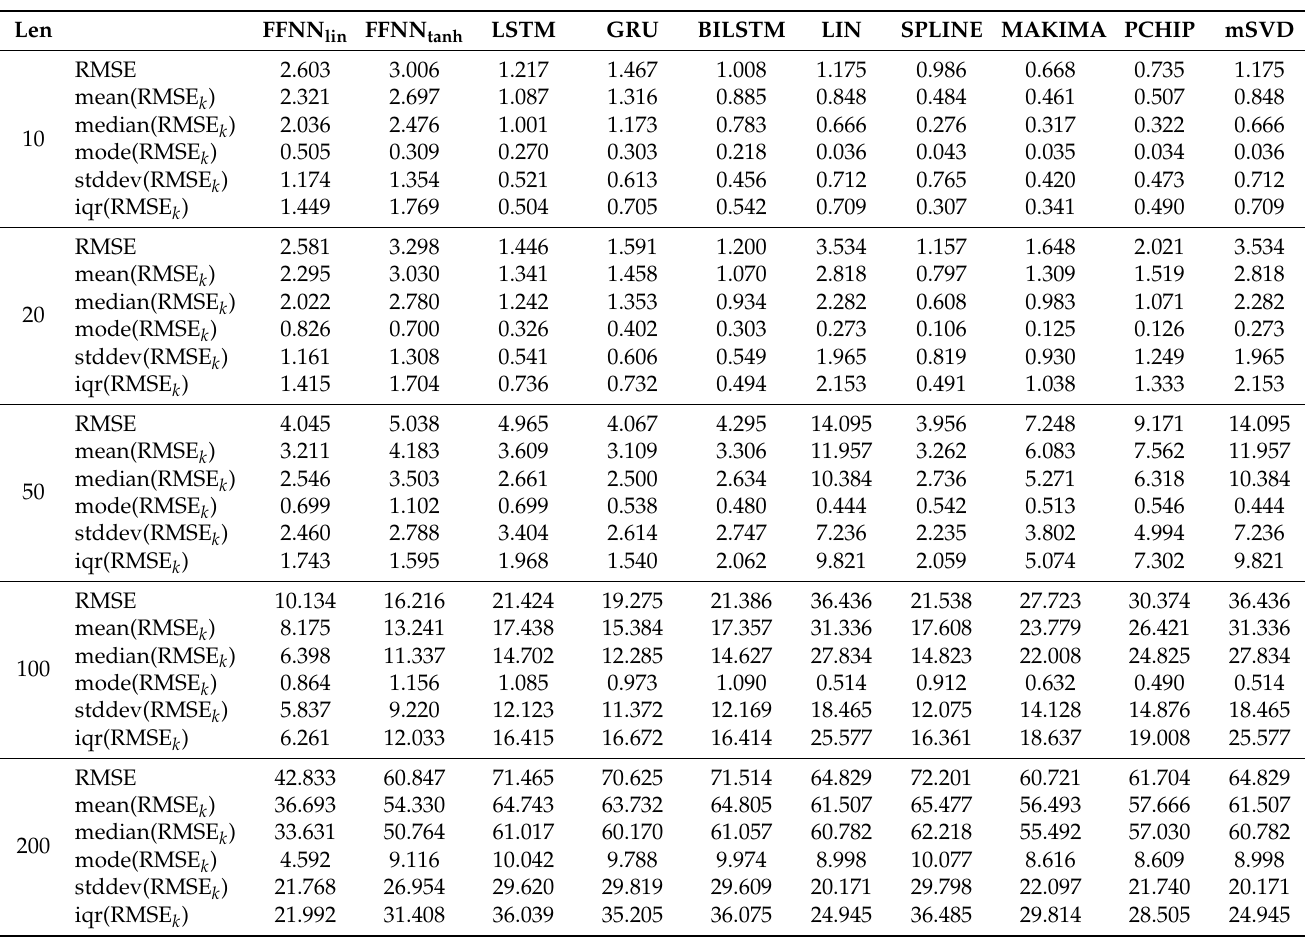
Table A4. Quality measures for the boxing (No. 5) sequence.